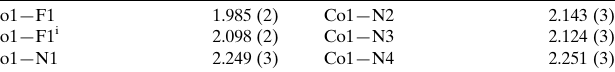
Selected bond lengths (A˚ ).